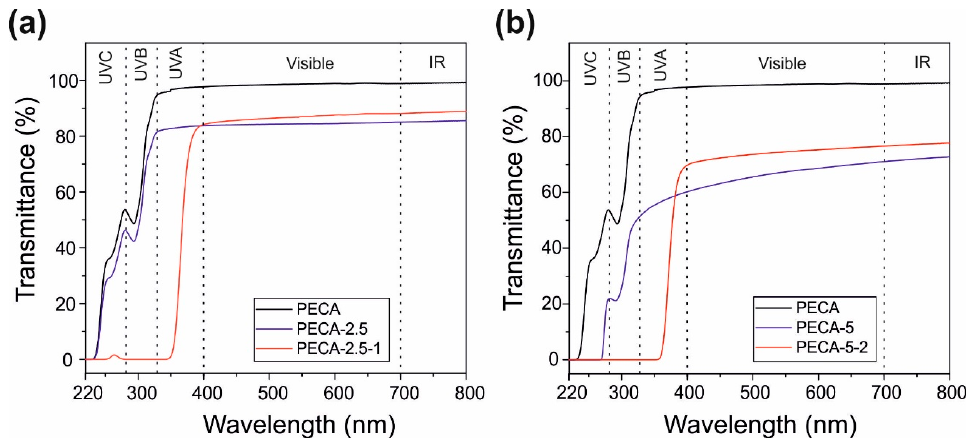
Figure 6. ( a ) The transmittance spectra of pristine PECA (in black), PECA blends in 2.5% wt. of PPC (PECA-2.5) and caffeic acid added in 1.0 wt.% (PECA-2.5-1). ( b ) PECA blends in 5.0% wt. of PPC (PECA-5) and caffeic acid added in 2% wt. (PECA-5-2). The PECA–PPC blends are shown in blue while the blends with caffeic acid are in red.